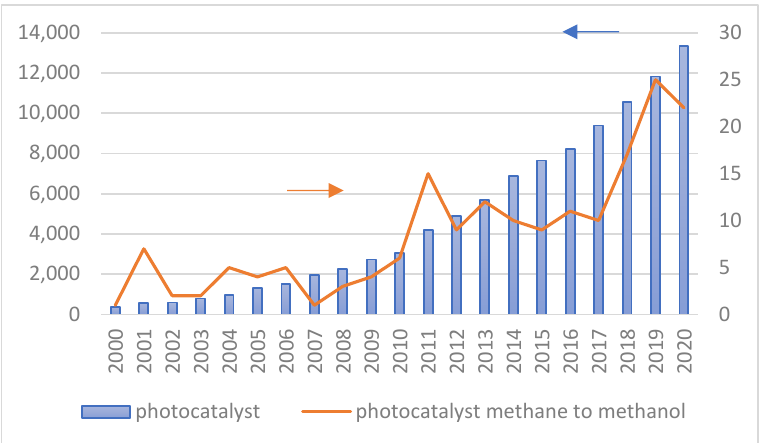
Figure 4. The number of research Scopus with TITLE–ABS–KEY photocatalyst–photocatalytic and photocatalyst–methane–methanol.